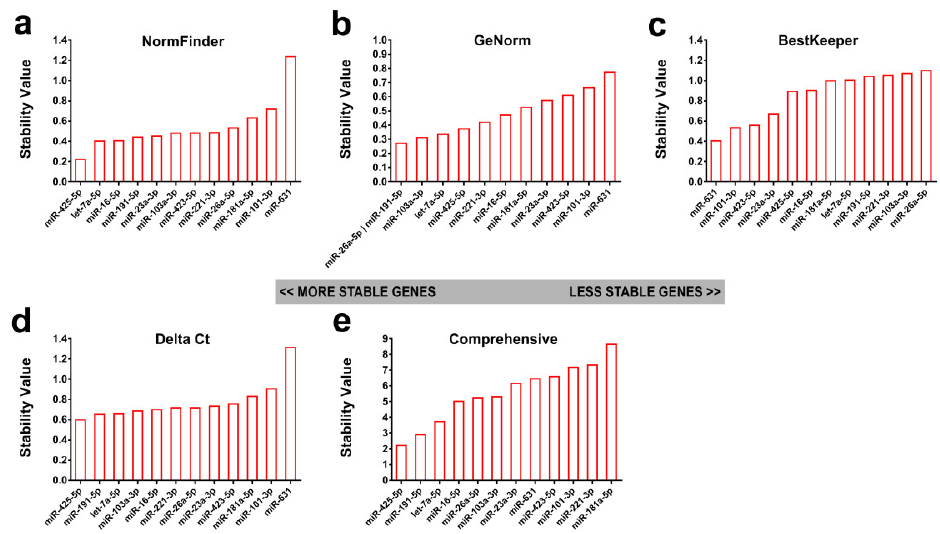
Figure 4. Identification of candidate RGs from qRT-PCR quantification data of 12 serum exomiRs in 42 subjects from a schistosomiasis-endemic area. Data were analyzed using ( a ) NormFinder, ( b ) GeNorm, ( c ) BestKeeper, and ( d ) Delta Ct. ( e ) A comprehensive ranking of candidate RGs was produced by RefFinder by integrating the results of the above four algorithms.